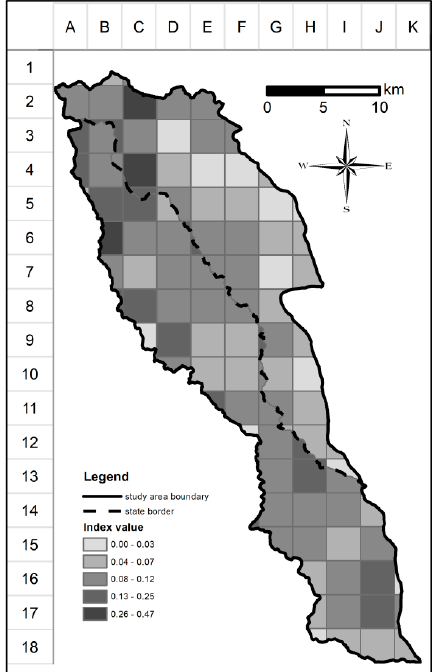
Figure 8. Synthetic index of tourism infrastructure density calculated by the HDI method. Source: authors’ own research.